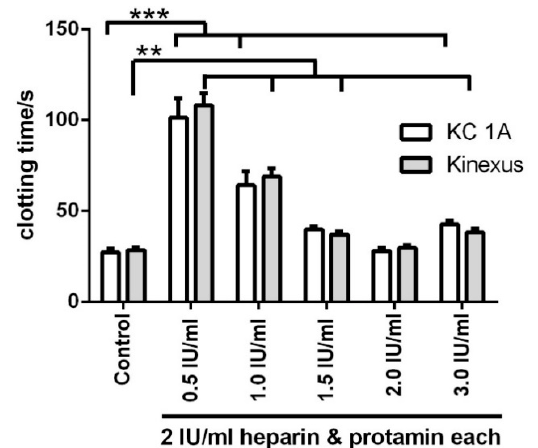
Figure A9. Clotting times of the back titration of heparin (2 IU/mL) with protamine (0.5–3.0 IU/mL) ( n = 3). The effect of the inhibitor heparin was reversed by various concentrations of protamine. The control measurement was citrated blood with Thromborel. The asterics above the bars indicate that this particular bar is significantly different from all others. Both devices provided similar clotting times and were thus comparable. The lowest protamine concentration of 0.5 IU/mL had a strongly delayed clotting time (CT). The mean CT of the equimolar concentration of protamine/heparin with 2 IU/mL was not significantly different from the clotting time of the control measurement. For Kinexus, the lower concentration of 1.5 IU/mL was also not significantly different from the control. ** p < 0.01, *** p < 0.001.